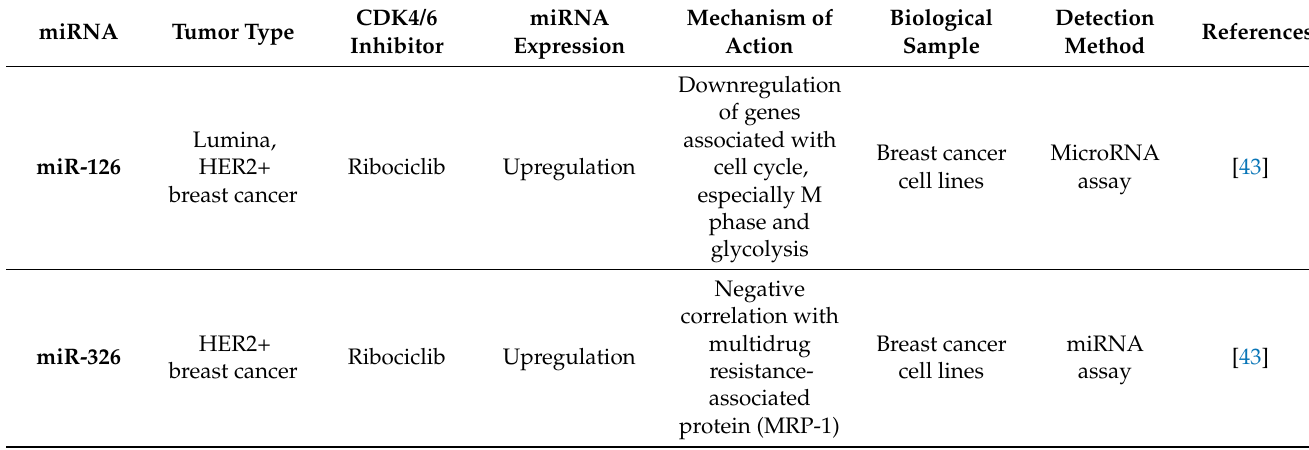
Table 1. MicroRNAs associated with sensitivity to CDK4/6